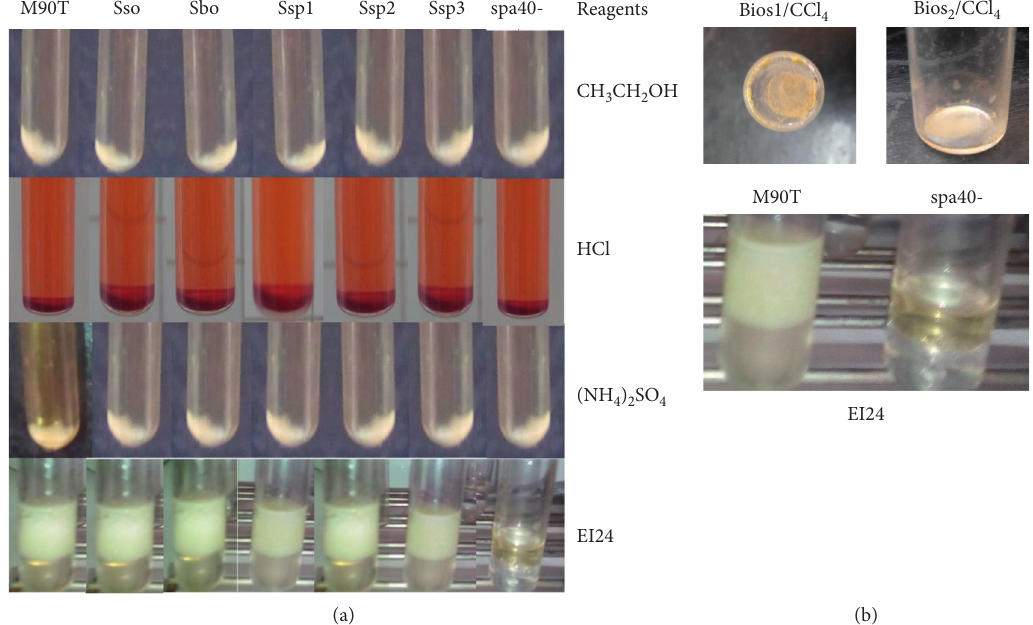
Figure 5: BLM purified from Shigella sp. TOP: profile obtained after precipitation with ethanol (CH 3 CH 2 OH), hydrochloric acid (HCl), and ammonium sulfate ((NH 4 ) 2 SO 4 ). EI24: emulsification index for all strains. S. flexneri M90T, S. sonnei , S. boydii , and Shigella sp.: Ssp1, 2, and 3. Bottom panel: residues obtained after evaporation of chloroform (CCl 4 ) (left); emulsification index (EI24) for the extractable bio- surfactant-like molecule (right). Bios1 and Bios2: biosurfactant-like molecule